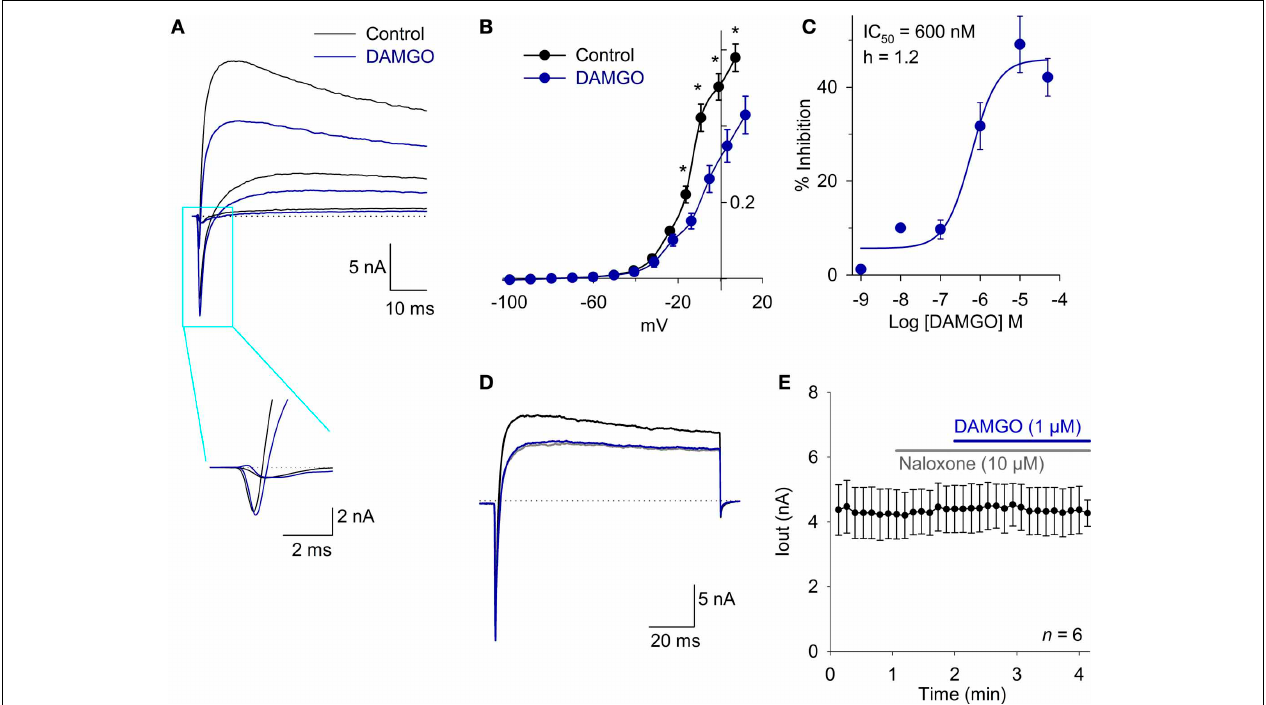
FIGURE 1 | The MOR activation inhibits an outward current in whole cell current recording. (A) Traces of whole cell total current showing inward and outward currents under control conditions and after 1 μ M DAMGO perfusion, the fast inward current (mainly attributable to Na + ) did not change, but the outward current (attributable to K + ) decreased significantly. Inset shows the fast inward current in a time expanded scale. The dotted lines indicate zero current. (B) The current-voltage relationship for the outward current showed a significant effect of DAMGO which decreased the maximum current 32% at 20mV. (C) Concentration response relationship for the DAMGO inhibitory effect on the outward